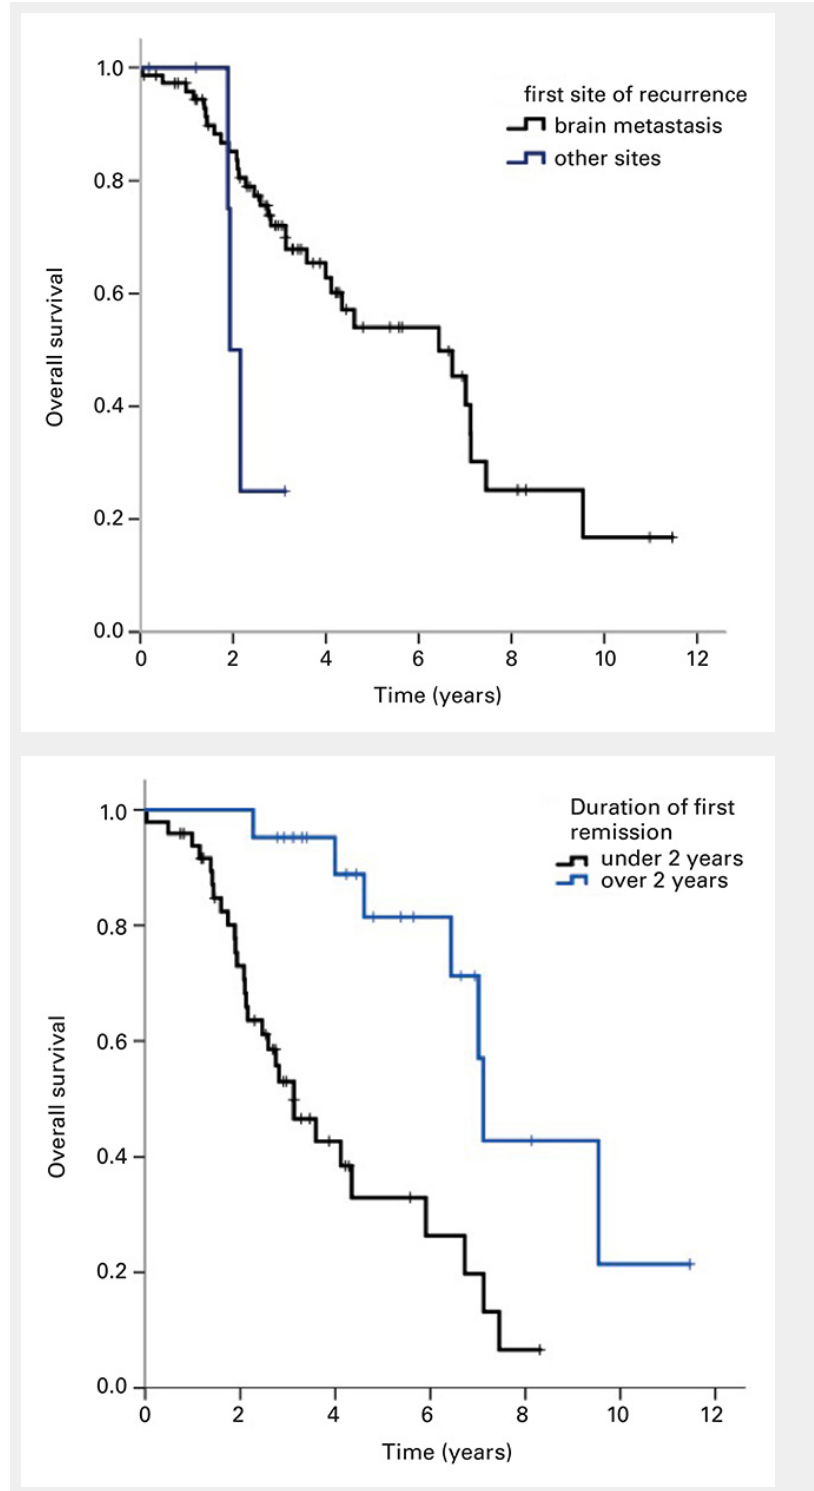
Figure 2 Kaplan-Meier curves of overall survival for ( a ) brain metastases as first site of recurrence vs other sites, p = 0.043 and ( b ) duration of first remission <2 years vs ≥2 years, p